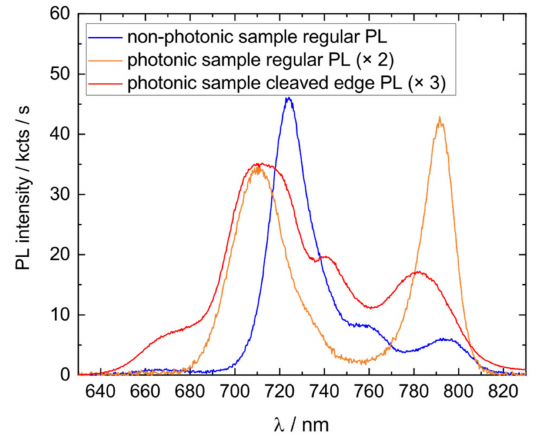
Figure 5. Comparison of regular ensemble PL emission of the photonic sample (orange line), non- photonic sample (blue line), and cleaved-edge PL of the photonic sample (red line). For better comparability, multiple factors were